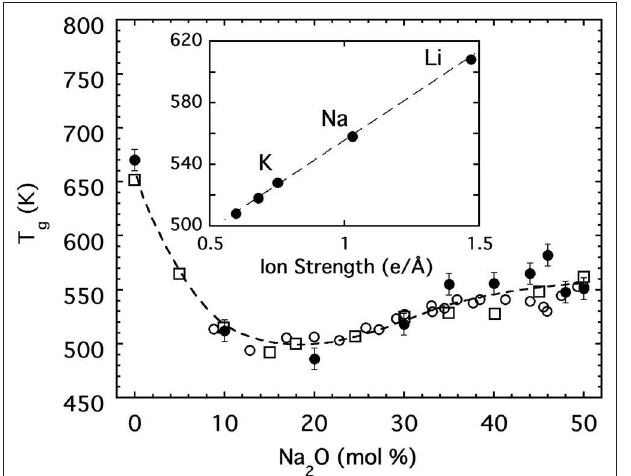
FIGURE 3 | The glass transition temperature for [Na 2 O] x [P 2 O 5 ] 1 − x glasses. Closed circles are values obtained from dynamic light scattering. Open symbols are literature values [(Eisenberg et al., 1966) (circles); (Hudgens et al., 1998) (squares)]. Dashed line is a guide for the eyes. The inset shows the glass transition temperature for metaphosphate glasses (x = 0.5) as a function of the ion strength.